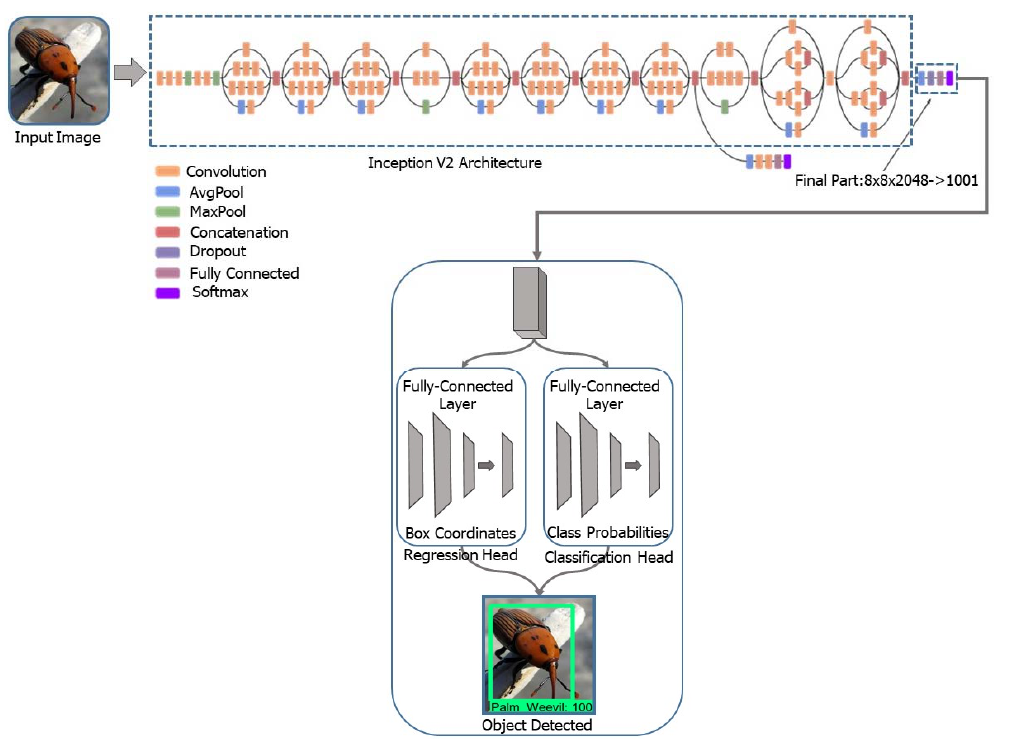
Figure 4. The overall architecture of the proposed model.